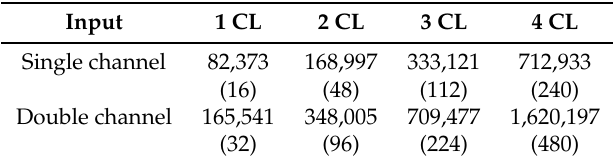
Table 9. Number of learnable parameters and filters (in brackets) of various network architectures under different input